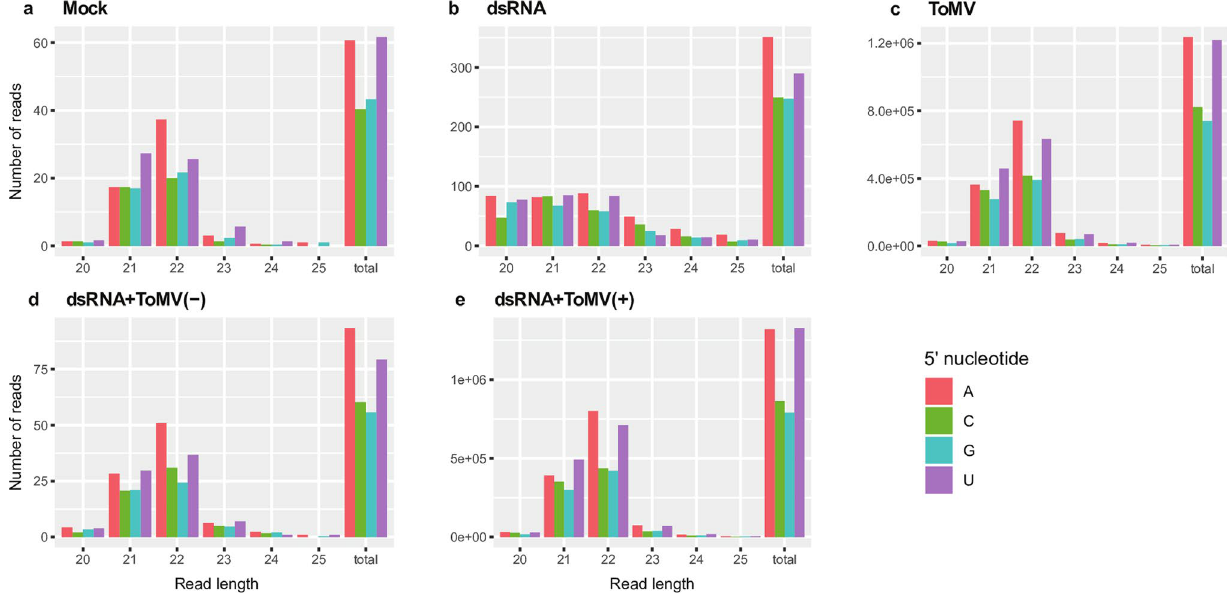
Figure 8. Small interfering RNA (siRNA) analysis in tomato plants, as identified by high throughput sequencing. Counts for each siRNA class according to its size and 5 ′ -nucleotide identity were examined in the five libraries [mock ( a ), dsRNA ( b ), ToMV ( c ), dsRNA + ToMV(−) ( d ), and dsRNA + ToMV(+) ( e )] using average values from three repetitions (each composed of four plants) per treatment. Columns in the histograms represent the number of reads for each siRNA size class between 20- and 25-nt. Colored bars represent the 5 ′ -nucleotide